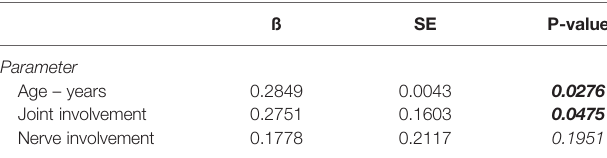
TABLE 3 | Multiple regression analyses of parameters attributed to females. ß SE P-value Parameter Age – years 0.2849 Joint involvement 0.2751 Nerve involvement 0.1778 0.2117 0.1951 Bold indicates statistically signi fi cant values. SE, standard